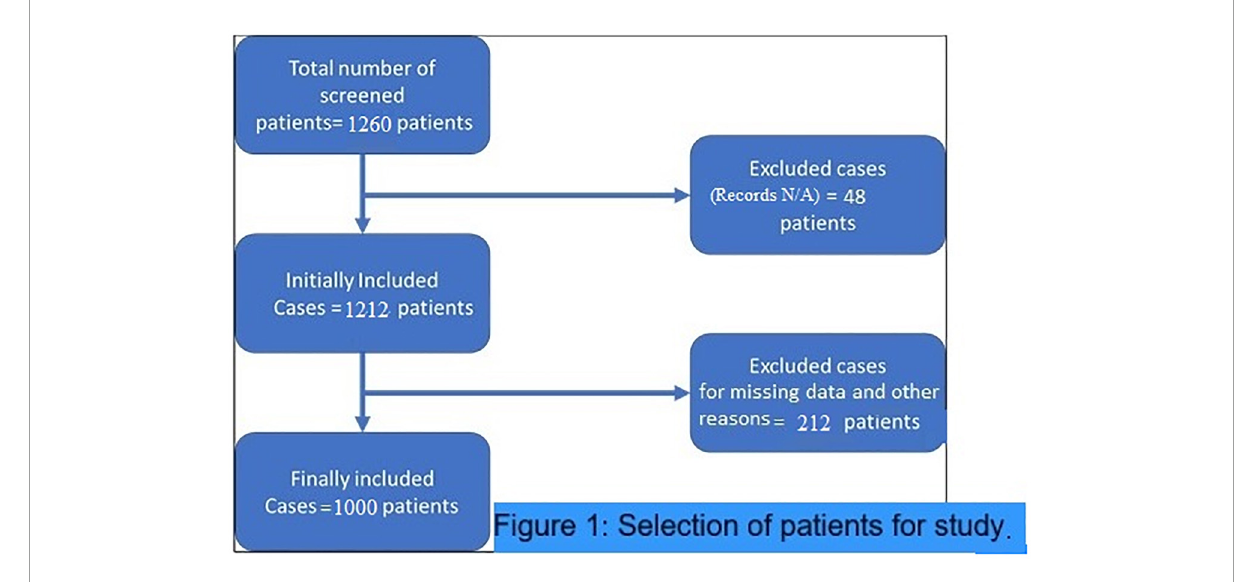
FIGURE1 Patient recruitment flow chart for the